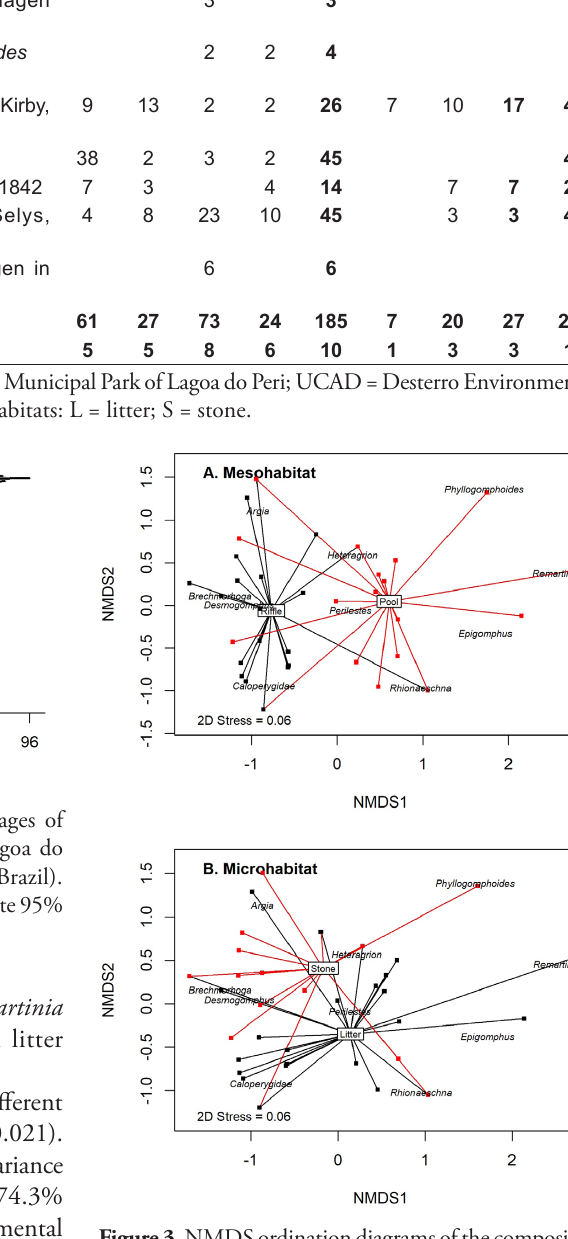
Figure 3. NMDS ordination diagrams of the composition of odonate assemblages according to (A) mesohabitats and (B) microhabitats (stress = 0.06) in streams in the island of Santa